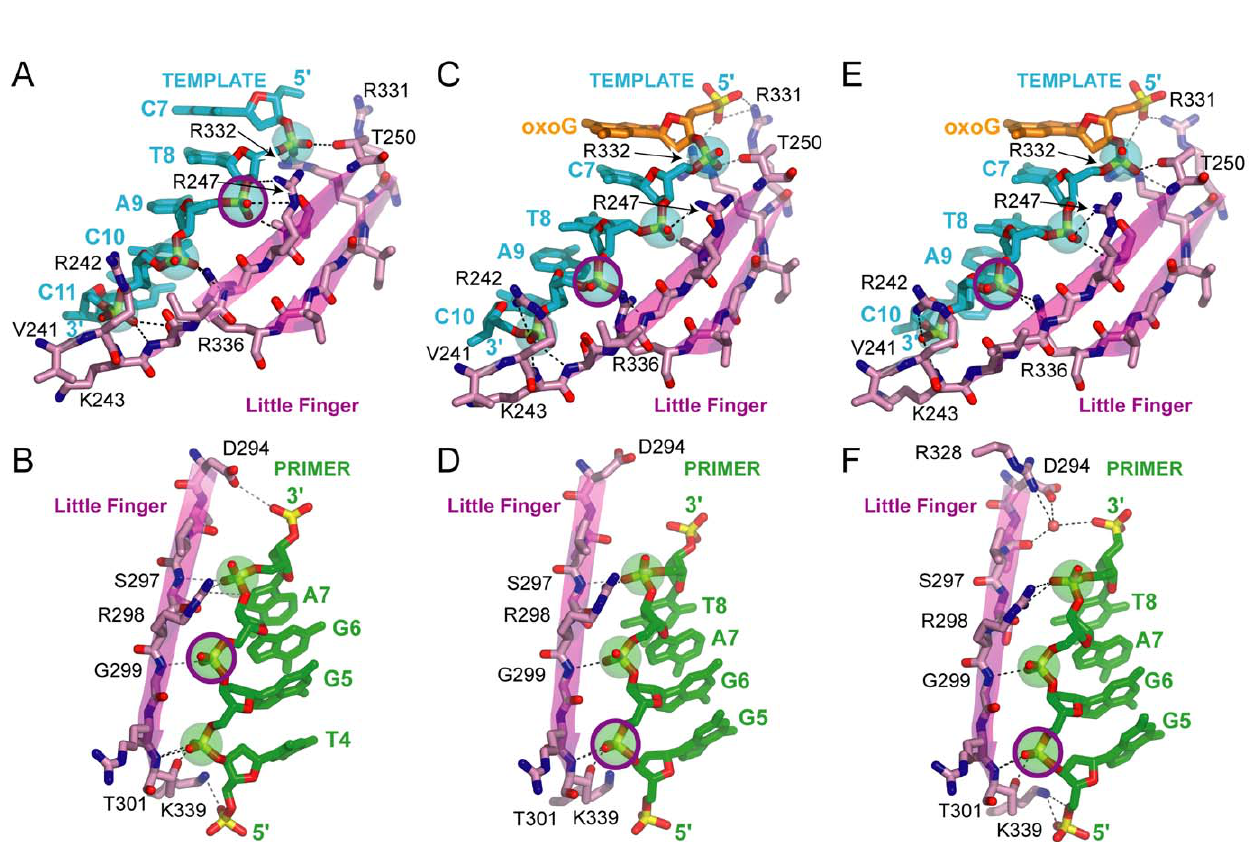
Figure 5. Details of Changes in Dpo4 Little-Finger Domain Contacts with Backbone Phosphates on the oxoG-Modified Template-Primer DNA Associated with the Nucleotide Binding and Incorporation Steps (A) Intermolecular contacts between the little-finger domain (purple) and the template strand (cyan) in the preinsertion binary complex. The phosphate groups interacting with Dpo4 amino acids are highlighted by shaded spheres. The phosphate group of A9 of the template strand is circled for reference. (B) Intermolecular contacts between the little-finger domain (purple) and the primer strand (green) in the preinsertion binary complex. The phosphate groups interacting with Dpo4 amino acids are highlighted by shaded spheres. The phosphate group of G6 of the primer strand is circled for reference. (C) Intermolecular contacts between the little-finger domain (purple) and the template strand (cyan) in the insertion ternary complex. The intermolecular contacts involving the little finger are translocated by one nucleotide step on proceeding from the preinsertion binary complex (in A)